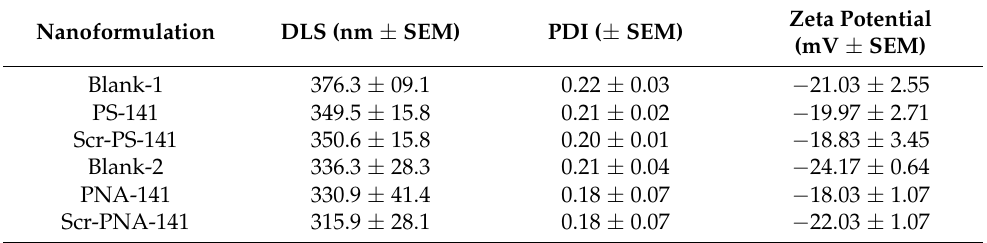
Table 1. Characterization of PLGA NPs containing antimiR-141 sequences. Mean diameter and polydispersity index (PDI) was calculated using dynamic light scattering (DLS), and the surface charge was calculated using zeta